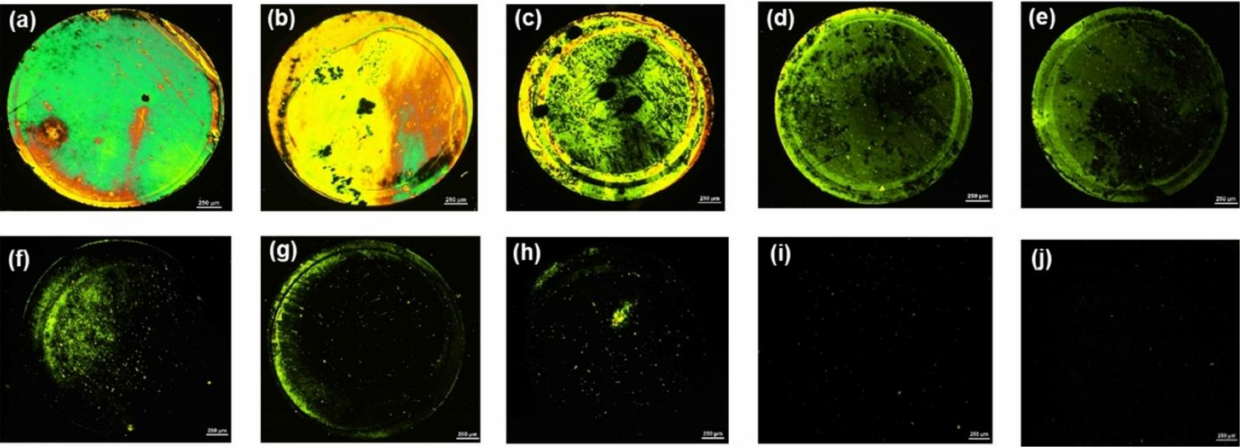
Figure 3. POM images of LC cells with AMX at the concentration of: ( a ) 1 µ M; ( b ) 800 nM; ( c ) 600 nM; ( d ) 400 nM; ( e ) 200 nM; ( f ) 100 nM; ( g ) 50 nM; ( h ) 10 nM; ( i ) 5 nM; and ( j ) 0 nM. Scale bar, 250 µ